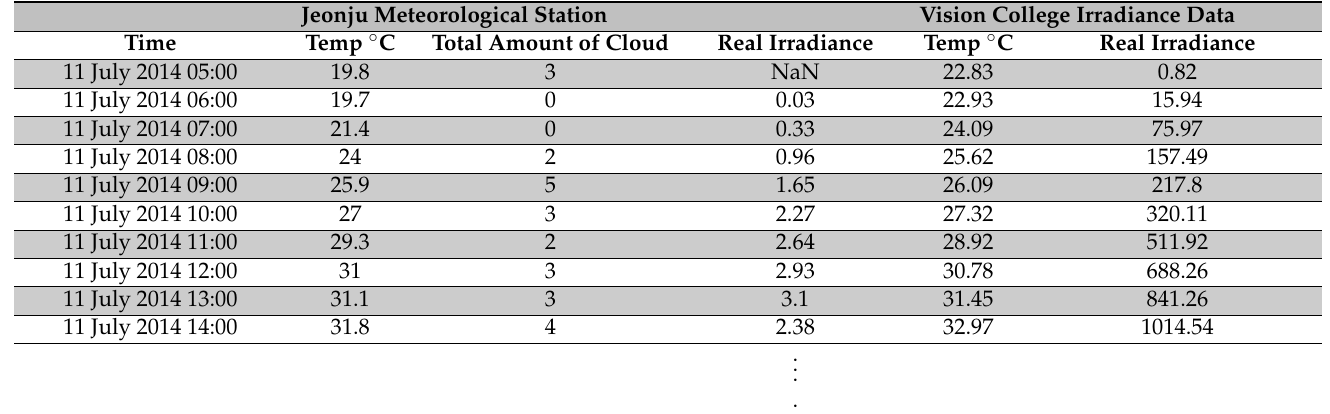
Table 3. Jeonju meteorological station & Vision college irradiance data [35.84092 ◦ 127.11718 ◦ 60m]. Jeonju Meteorological Station